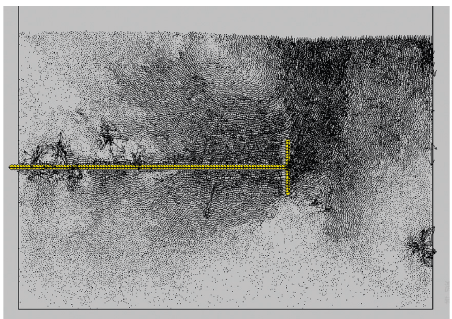
Figure 13: Displacement vector diagram of the soil particles.